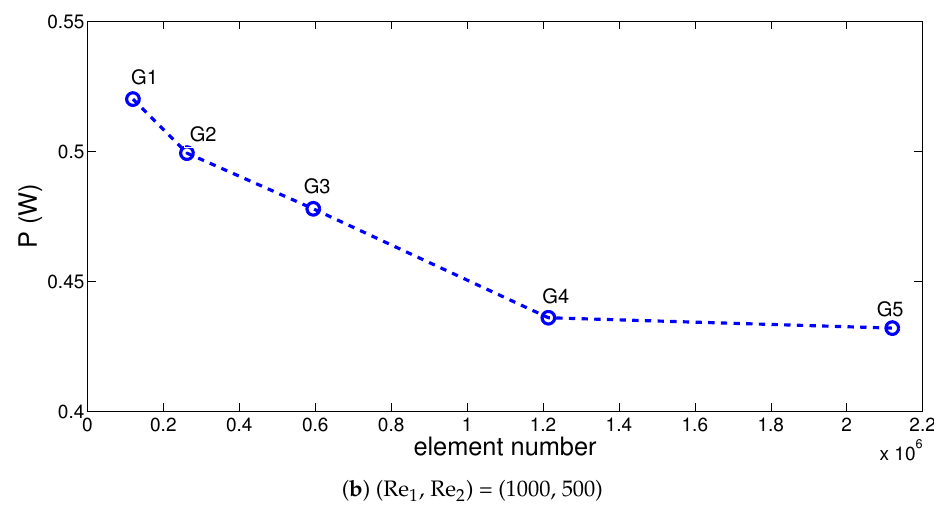
Figure 2. Mesh independence test results for two different jet stream Reynolds number combinations ( (r 1 , r 2 ) = (1, 1), z h = 3w s , φ = 0.02). The numerical code is validated by using different sources available in the literature.